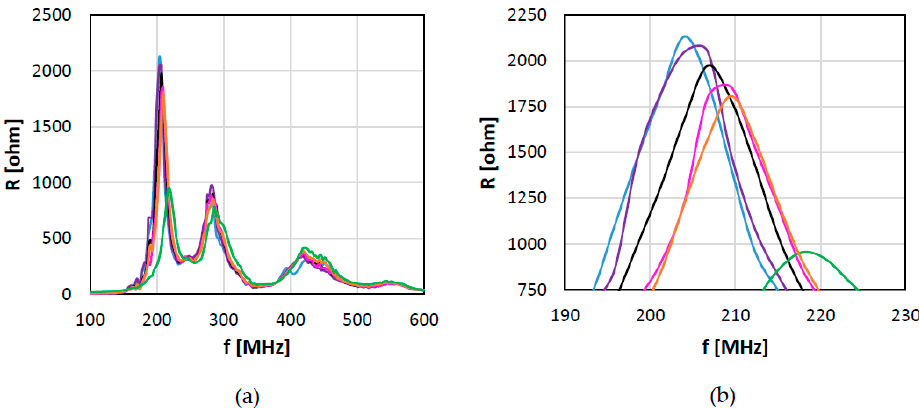
Figure 2. Spectra of R ( a ) and values of the maximum peak in the restricted range considered for the measurements ( b ), for water ( – ), 1-propanol ( – ) and water–ethanol mixtures with ethanol molar fraction of 0.007 ( – ), 0.219, ( – ), 0.495 ( – ), and 0.854 ( – ).